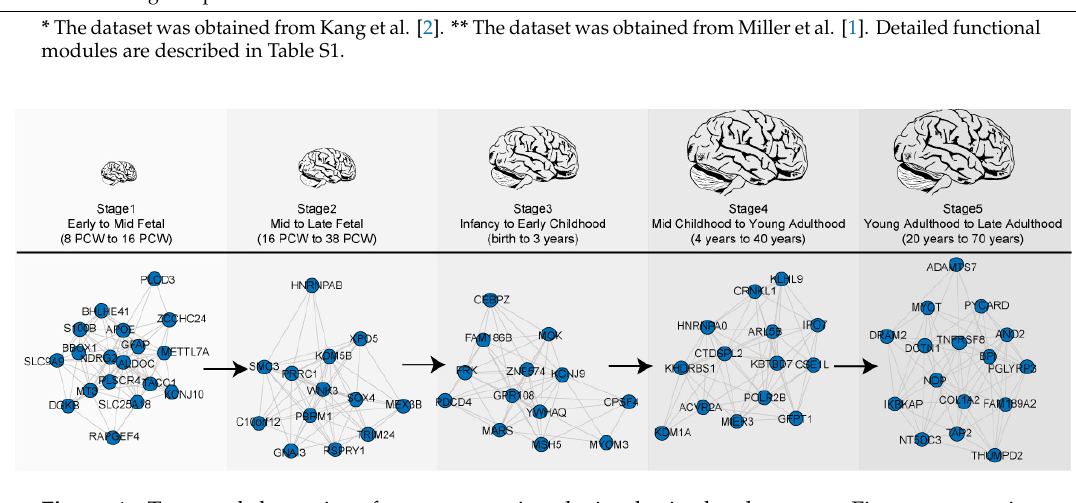
Figure 1. Temporal dynamics of gene expression during brain development. Five co-expression networks are highlighted by changes in co-expressed genes associated with chromatin/transcriptional regulation over developmental stages.